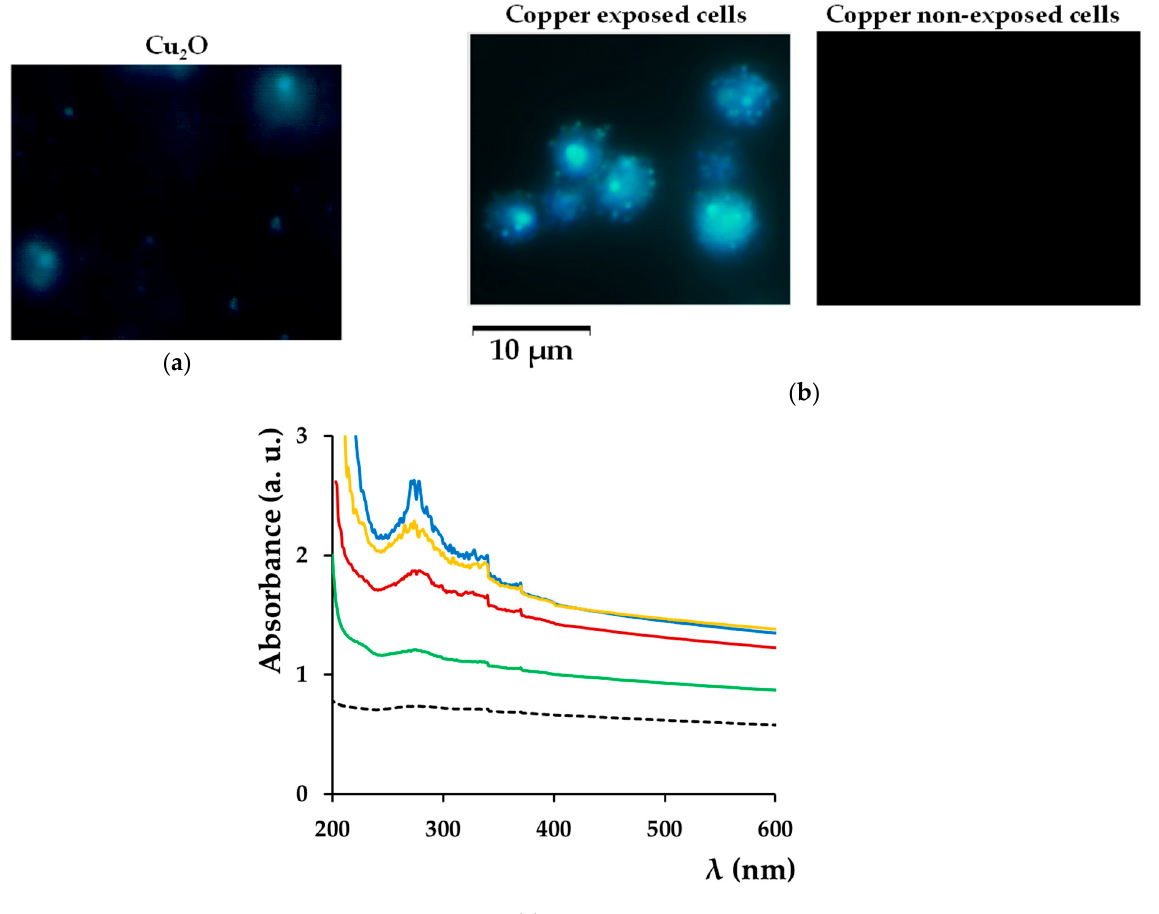
Figure 7. Optical properties of copper-exposed cells. Light scattering by Cu 2 O particles ( a ) or by cells exposed to copper ( b ). BY4741 cells were grown for 6 days on MM/Glc with or without 0.1 mM CuCl 2 before being observed microscopically in dark field. ( c ) UV–Vis spectra. Cells were processed as described in Section 2. Spectra correspond to cells grown for 6 days on solid MM/Glc (blue line), MM/Gal (Yellow), or MM/Gly (green) containing 0.1 mM CuCl 2 or in MM/Glc without CuCl 2 (black dotted line). Spectrum of Cu 2 O particles (red line) was included as control.